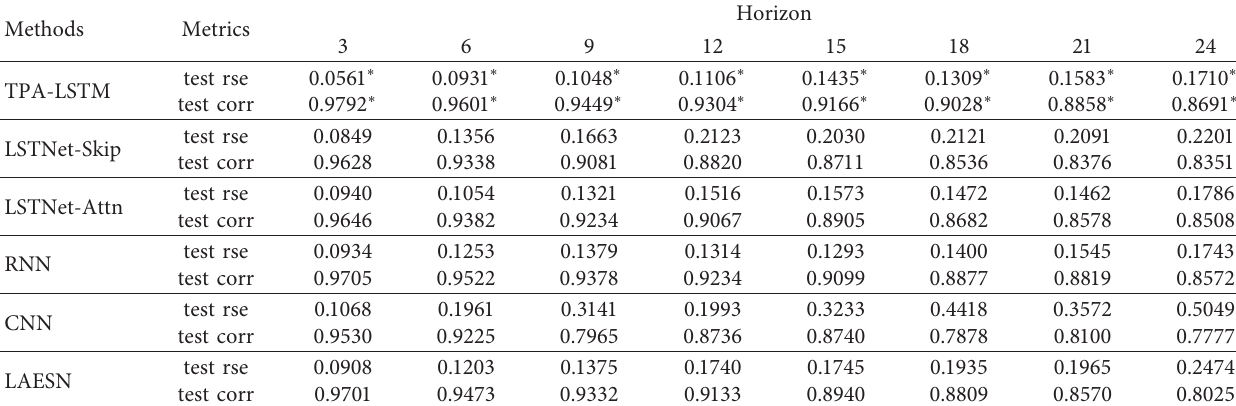
Table 2: Performance comparison of different